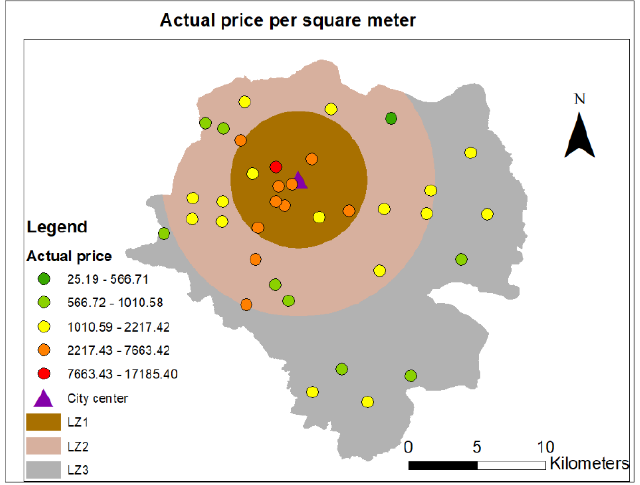
Figure 5. Urban actual land lease price (in USD) distribution by Woreda (the smallest administrative unit) centers. Each land price point is the mean value of land prices quoted in the Woreda.